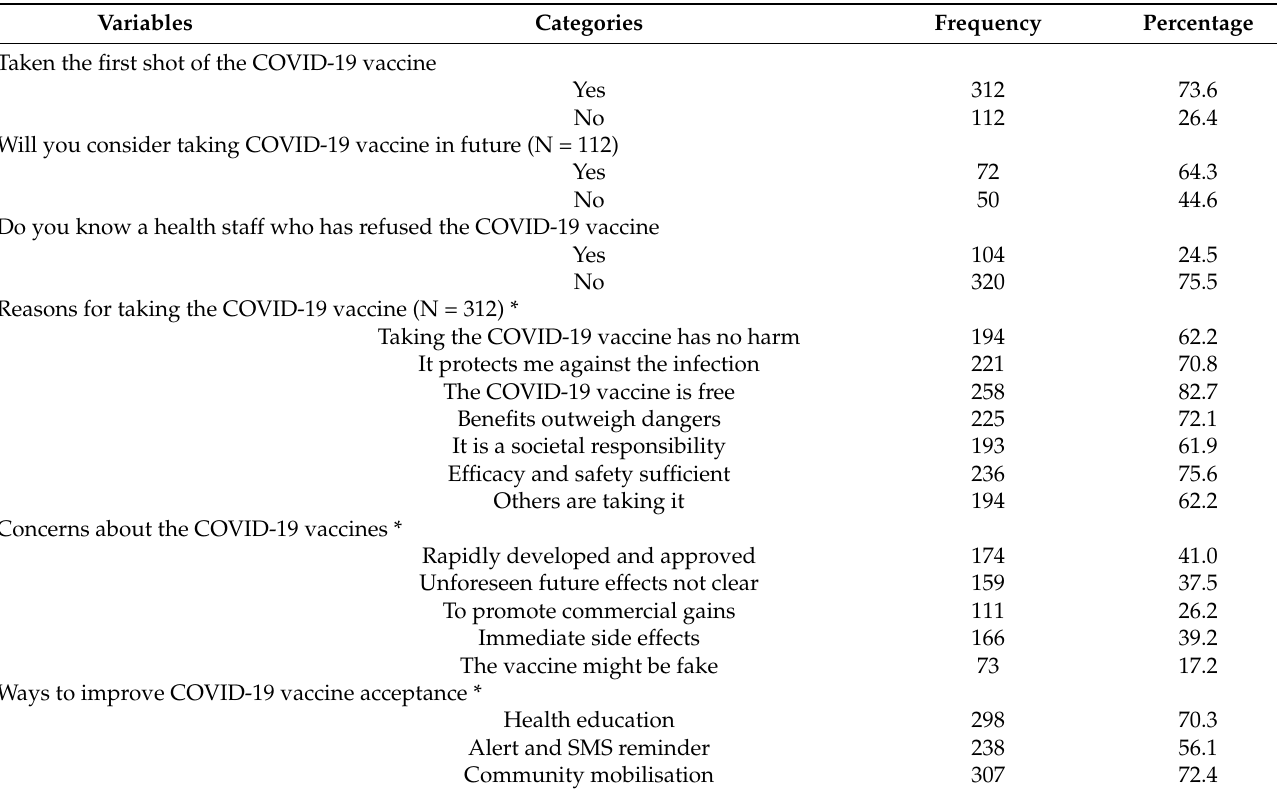
Table 3. COVID-19 vaccine acceptance and hesitancy (N =